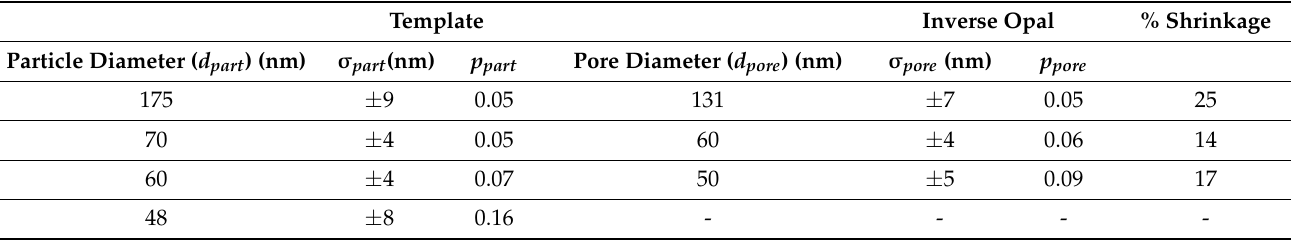
Table 2. Average diameters d, standard deviations σ and polydispersities p = σ / d of the template particles and their corresponding ZnO IO pores obtained after three mineralization cycles and extraction with toluene. The % shrinkage is also